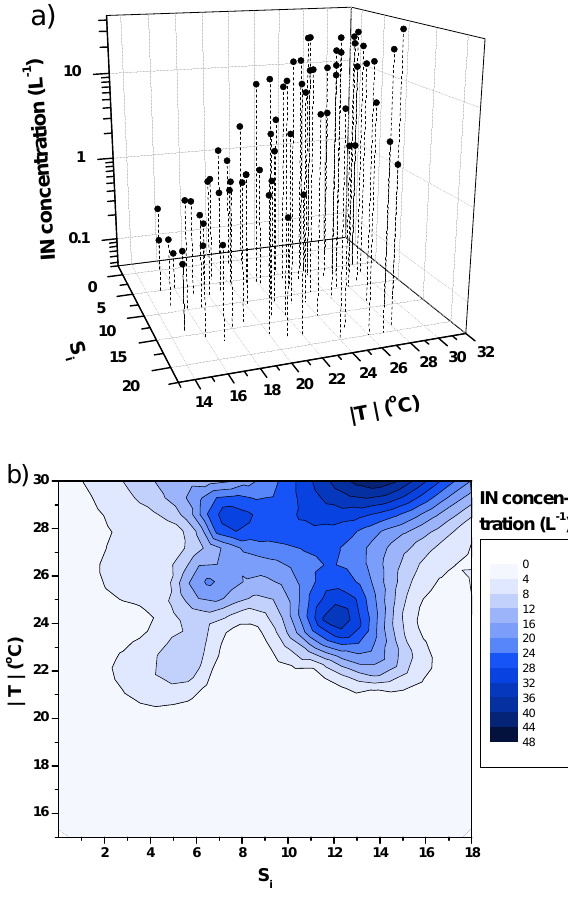
Fig. 4. (a) Three-dimensional plot representing IN concentration for different temperatures and supersaturations, (b) the corresponding interpolated data in color